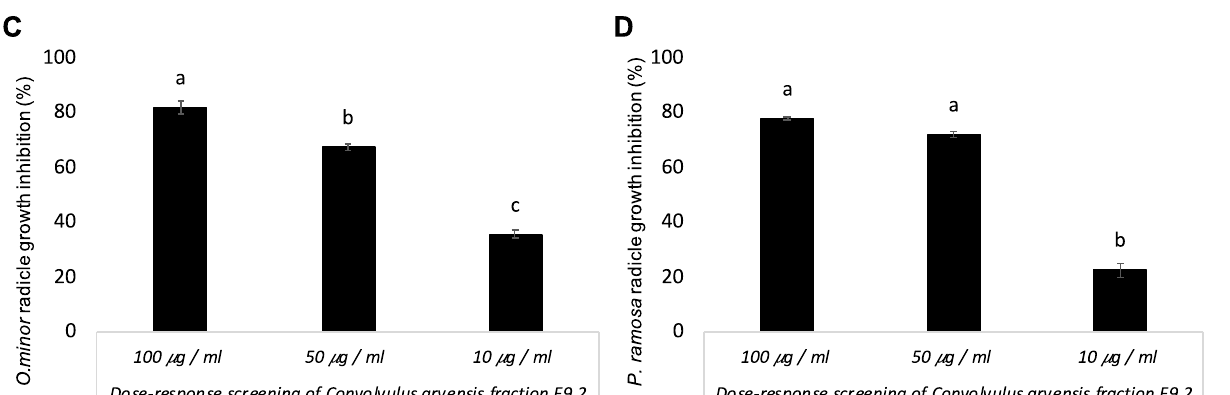
Figure 3. Dose – response curve of the phytotoxic activity of Convolvulus arvensis fraction F9.2 on radicle growth expressed as a percentage with respect to the growth of radicles treated with control treatment GR24 of ( A ) Orobanche crenata , ( B ) Orobanche cumana , ( C ) Orobanche minor and ( D ) Pheli- panche ramosa . Analysis of variance was applied to transform replicate data. For each broomrape species, bars with different letters are significantly different according to the Tukey test ( p = 0.05). Error bars represent standard error.